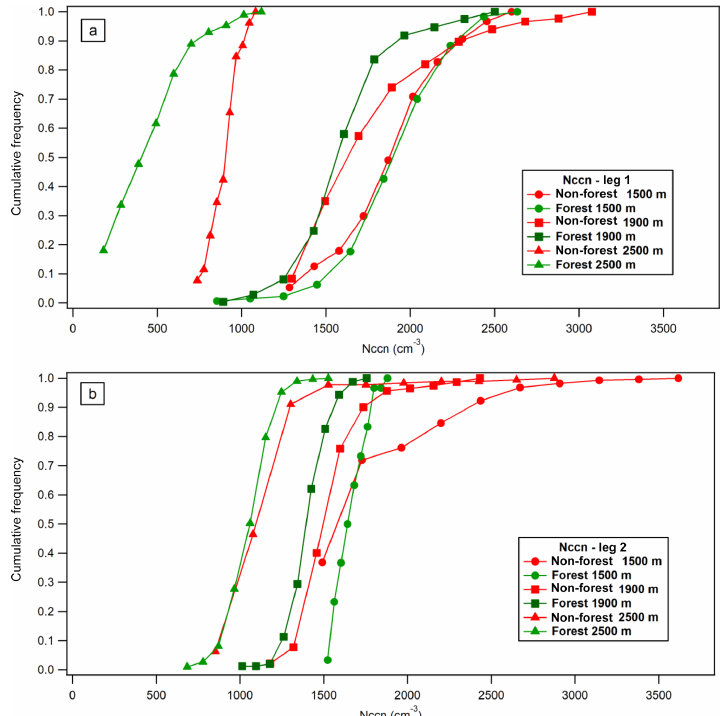
Figure 12. CCN concentration ( N CCN ) cumulative histogram for (a) leg 1 and (b) leg 2 of AC17 flight paths over forested and non-forested regions at different flight